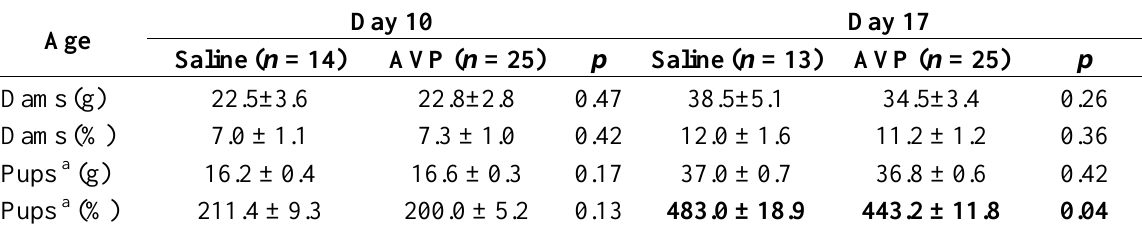
Table 3. Means ± SEM of absolute (g) and percent (%) body weight gain relative to lactation day 3 for Saline and AVP dams and pups on days 10 and 17. Data in bold represent significant differences between saline and AVP treated